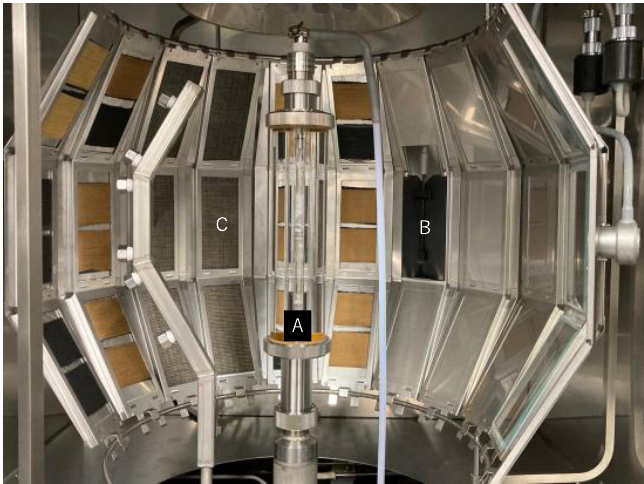
Figure 3. Example of test frame placement in Xenon-arc weathering meter. The letters “A”, “B”, and “C” represent the xenon-arc lamp, the black panel thermometer, and the test frame with two yarn specimens, respectively.